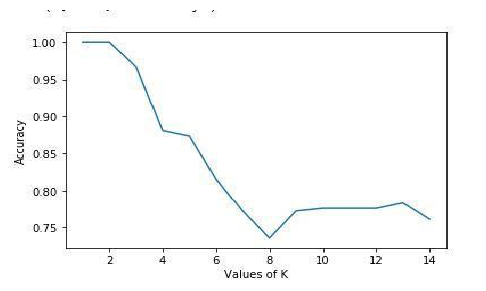
Figure 6. Collaborative Filtering Diagram